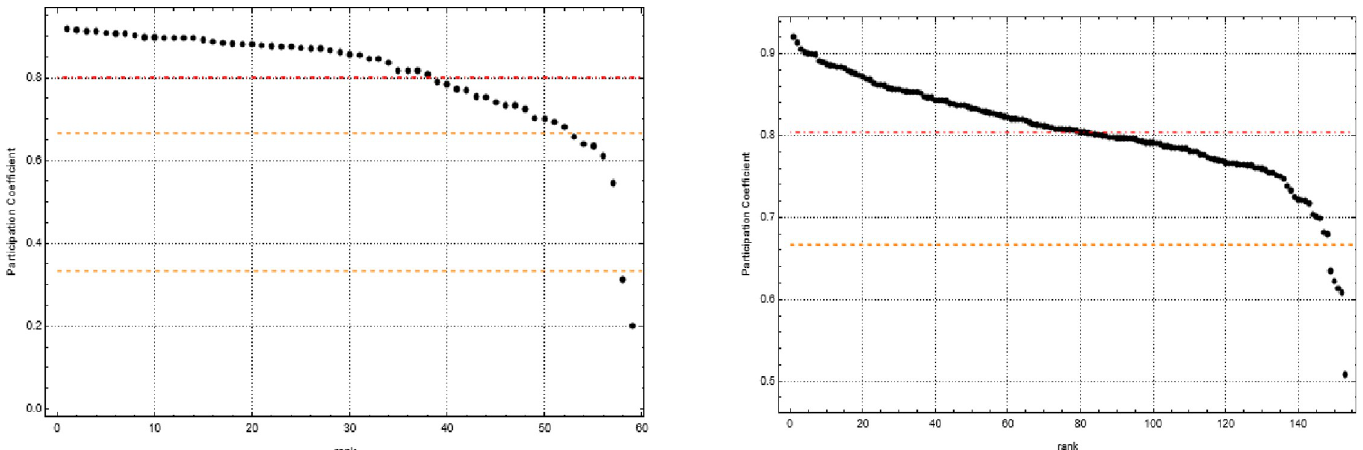
Fig 2. Rank distribution of participation coefficients for Central and Eastern Europe regions (left hand side) and the Western Europe regions (right hand side). Note : Orange dashed lines represent focuses, red dot-dashed lines represent average participation coefficients.